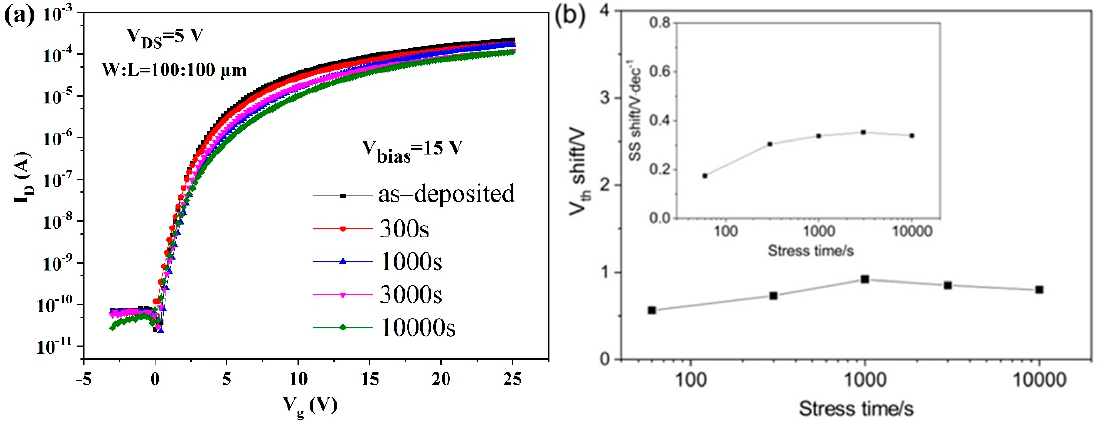
Figure 8. Transfer curves with SHS-based a-IGZO TFT. ( a ) Under different PBST; ( b ) the V t h shift of vs. PBST (inset is the SS shift of vs. PBST).